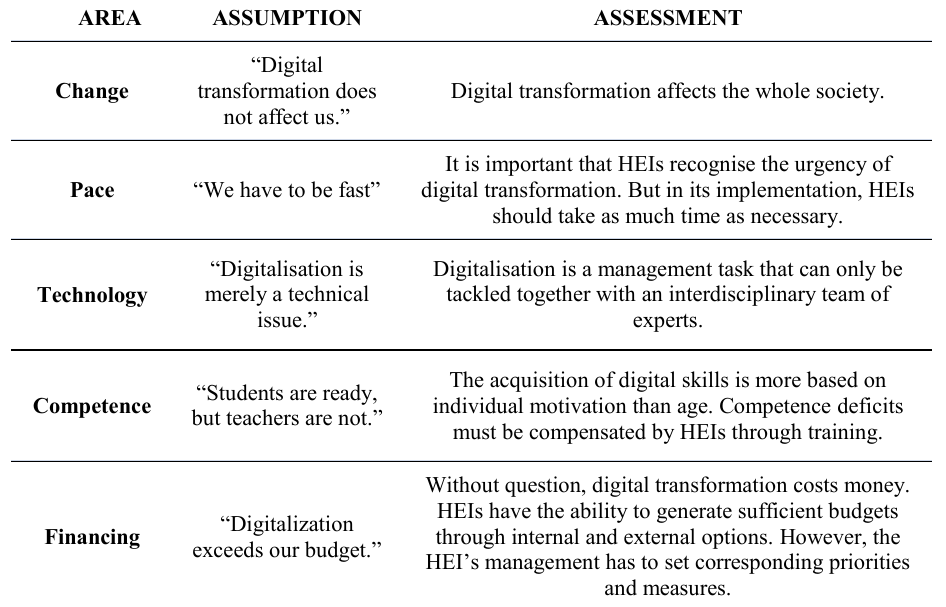
Table 1. Evaluation and suggestions about digital